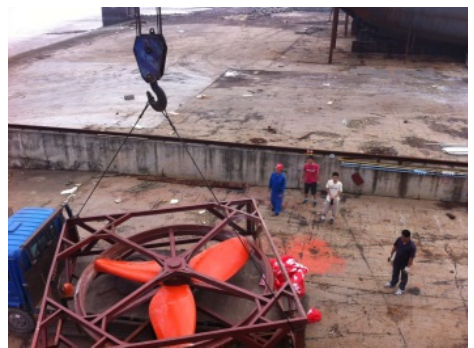
Figure 8. Rotor installation.